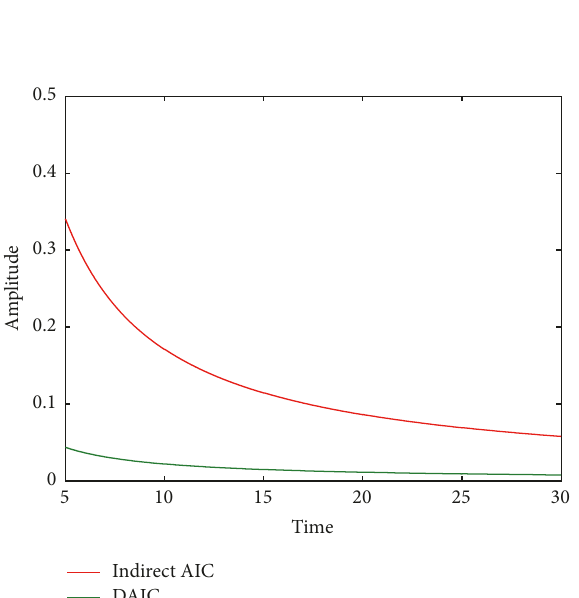
Figure 11: Control input.